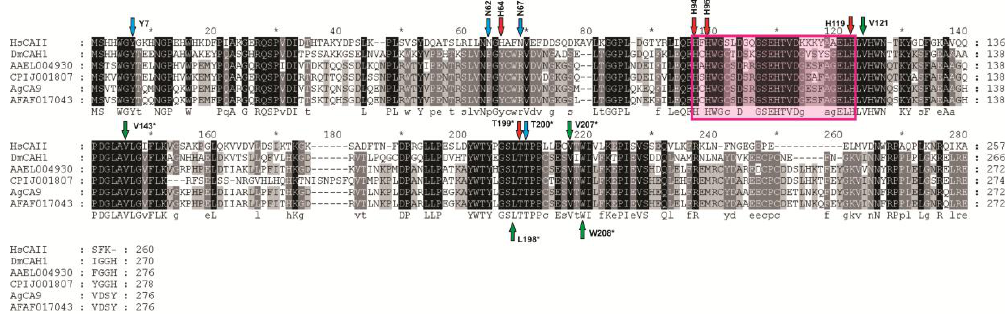
Figure 5. MUSCLE alignment of AeCA9 and its orthologues. AeCA9 (AAEL004930) was aligned with its orthologous sequences in Homo sapiens (HsCAII), Drosophila melanogaster (DmCAH1), Culex quinquefasciatus (CPIJ001807), Anopheles gambiae (AgCA9), and Anopheles farauti (AFAF017043). Homo sapiens CAII was used as a guide to map out the residues in Aedes aegypti that make up the active site and support active site structure (red arrows). Also, amino acids that stabilize the active site water molecules (blue arrows) and form the CO 2 binding pocket (green arrows) were mapped onto the alignment. The residues are highlighted in a graded fashion using the following shades that represent amino acid percent identity: Black (100% identity), Dark gray (80% identity), Light gray (60% identity), no shade (no similarity). The pink box overlaying the alignment indicates where the Human CAII active site is relative to the insect CAs (Human His94 through His119).